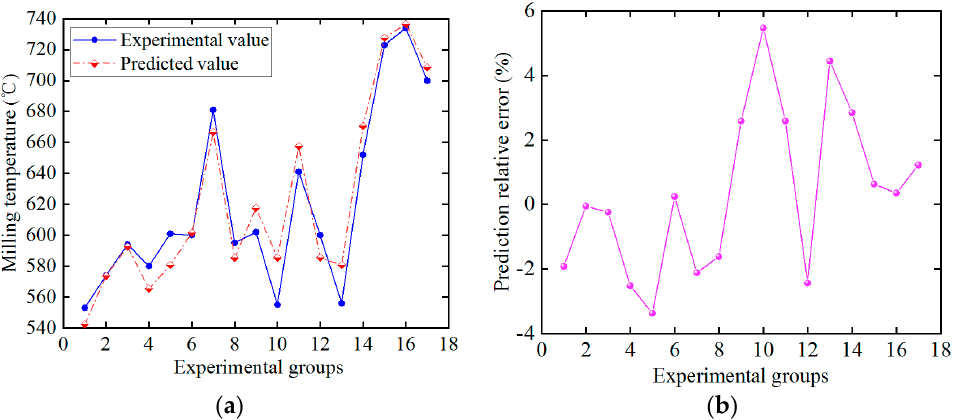
Figure 9. Temperature prediction. ( a ) Comparison of experimental and predicted value, ( b ) Relative error.